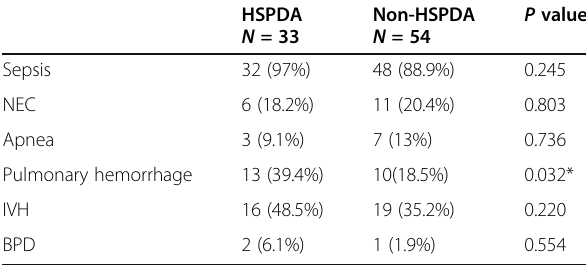
Table 4 Comorbidities between HSPDA group and non